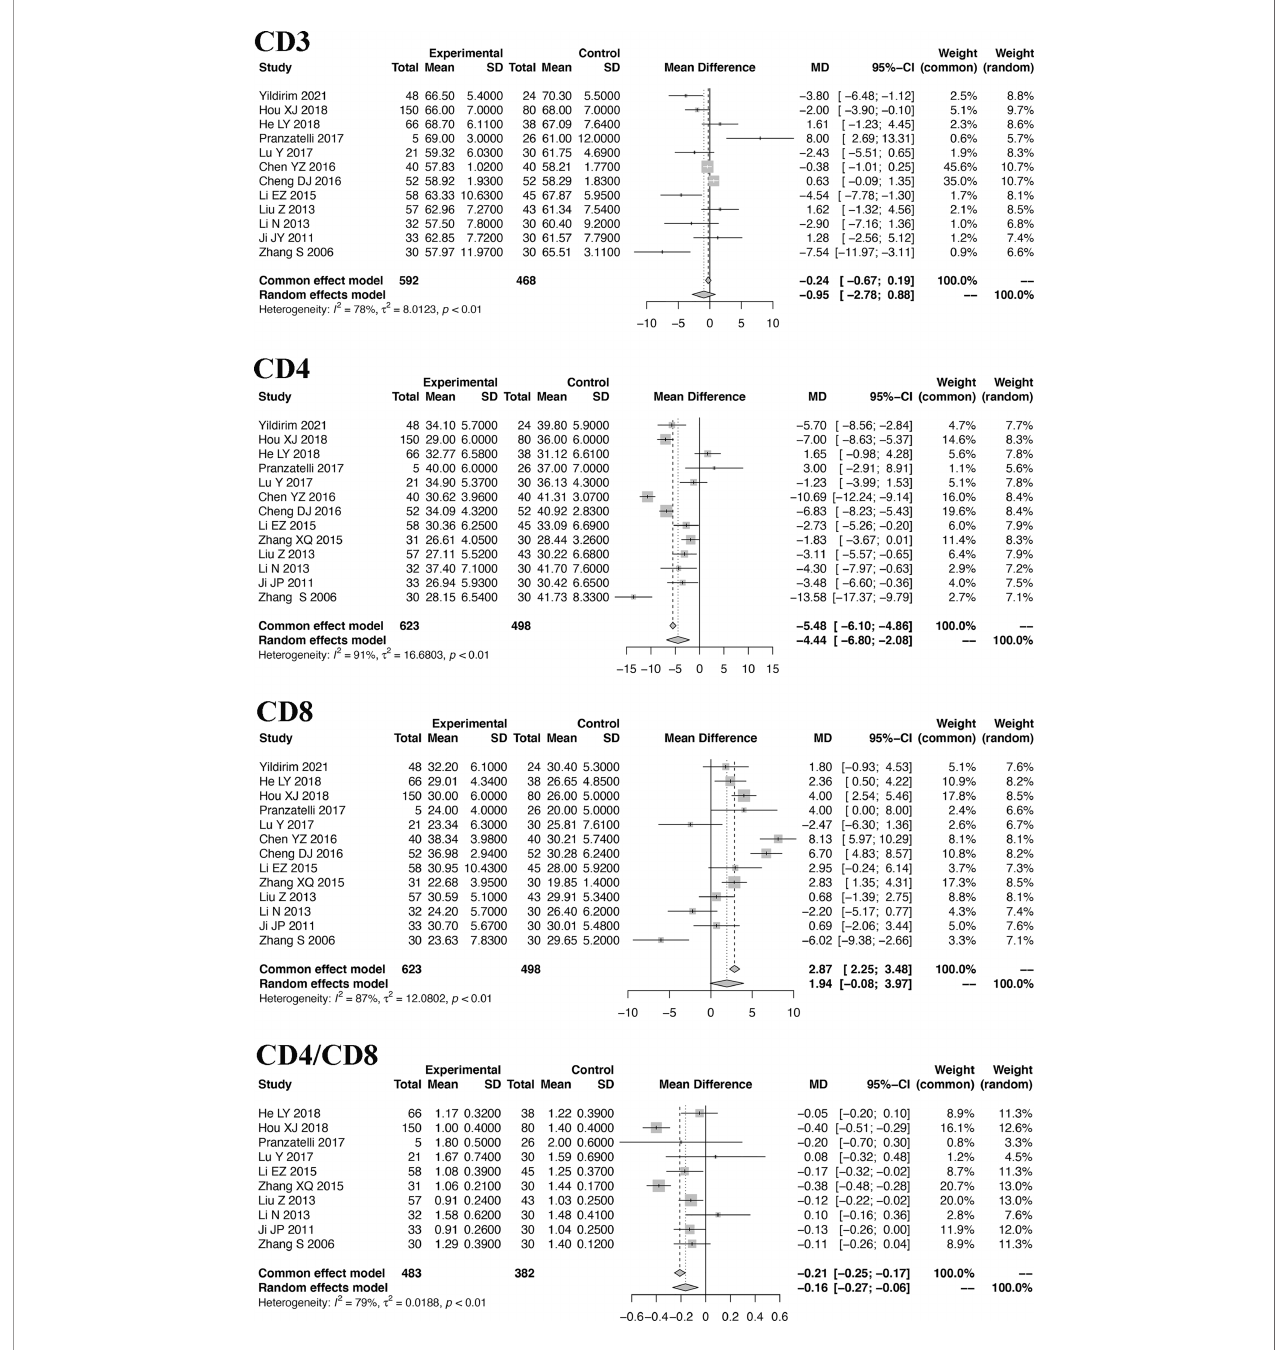
FIGURE 2 | Forest plot of the meta-analysis of T